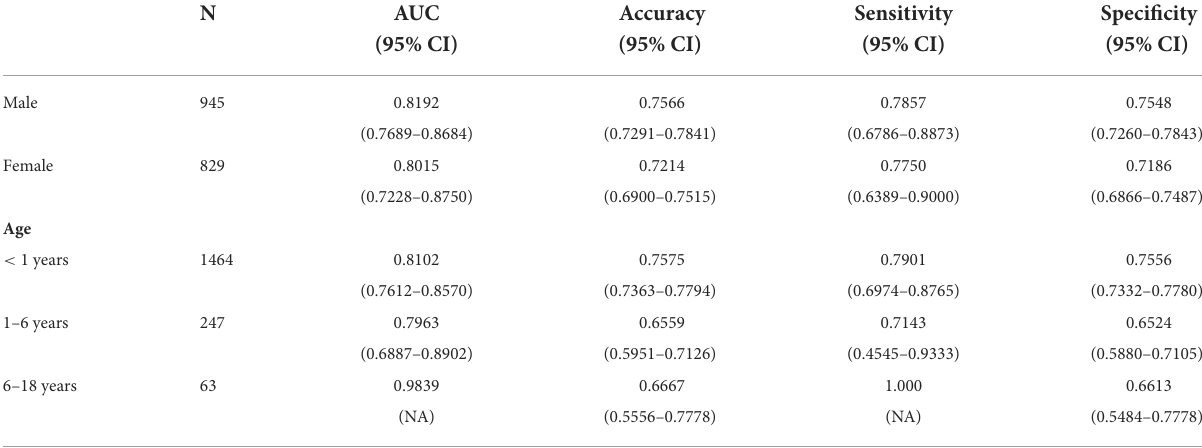
TABLE 4 Performance evaluation of the CatBoost model using the validation